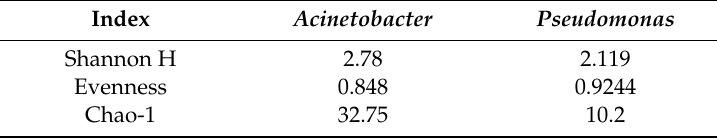
Table 5. Alpha diversity indices calculated on RAPD profiles for Acinetobacter and Pseudomonas